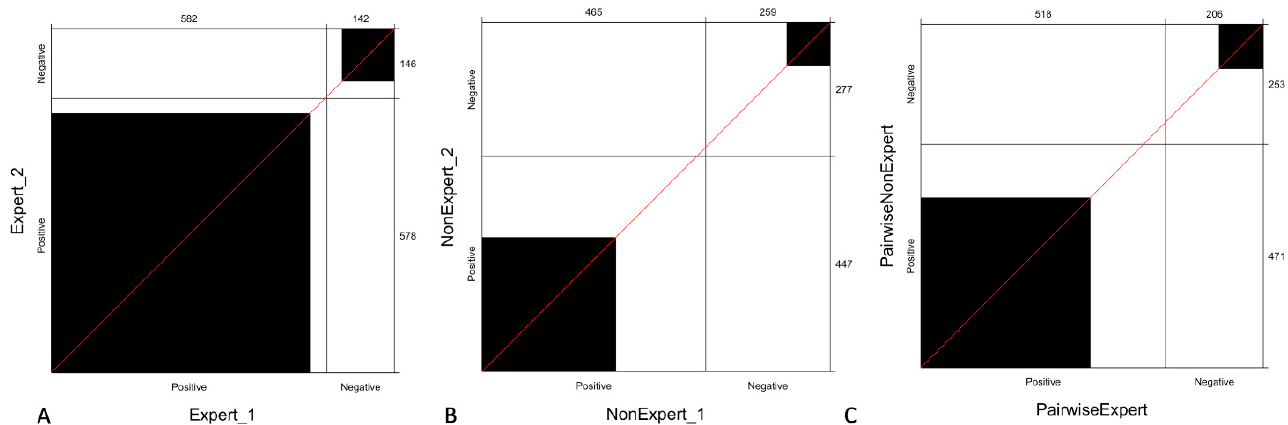
Figure 3. Agreement of readers stratified by experience: the panel shows the observed agreement between expert readers ( A ), non-expert readers ( B ) and pairwise observed agreement between expert and non-expert readers ( C ). The black square area indicates the exact observed agreement between the two operators while the white remaining area indicates the disagreement. We can observe that the agreement between expert readers is higher ( A ) compared to that observed with non-expert ( B ) or pairwise expert and non-expert readers ( C ).